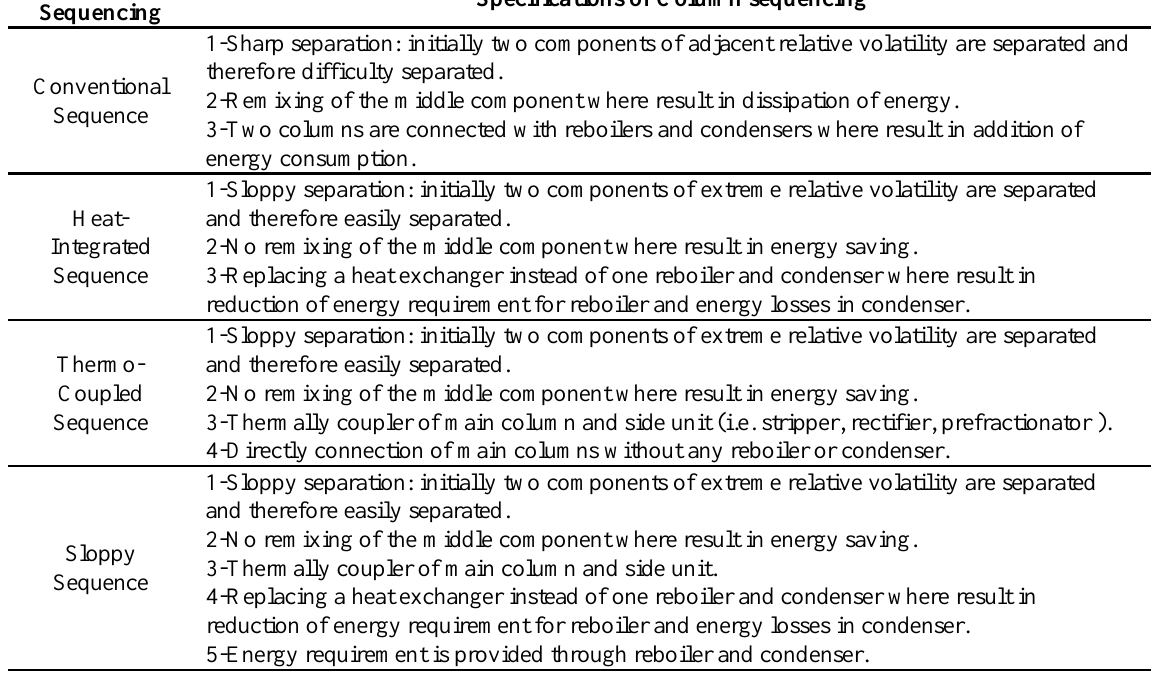
Specifications of Column sequencing